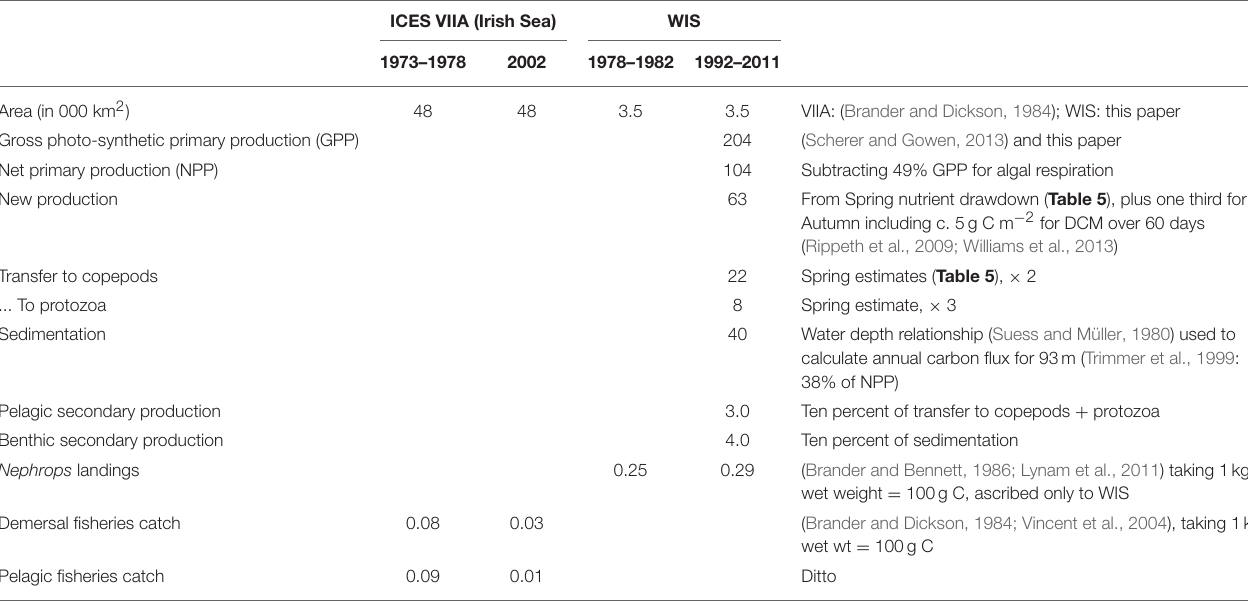
TABLE 7 | Estimates of annual production (g C m − 2 a − 1 ) in the WIS and ICES VIIA at several trophic